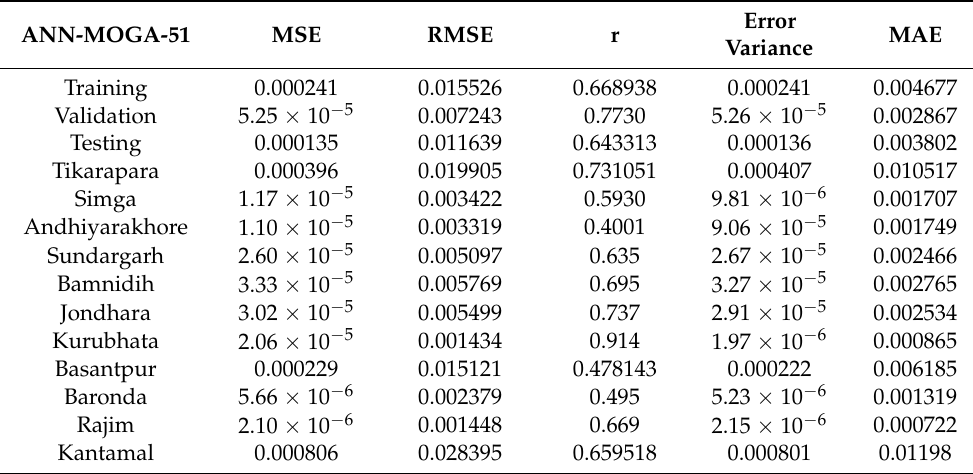
Table 5. Error statistics of ANN-MOGA-51 forecasting model during validation, testing, and training